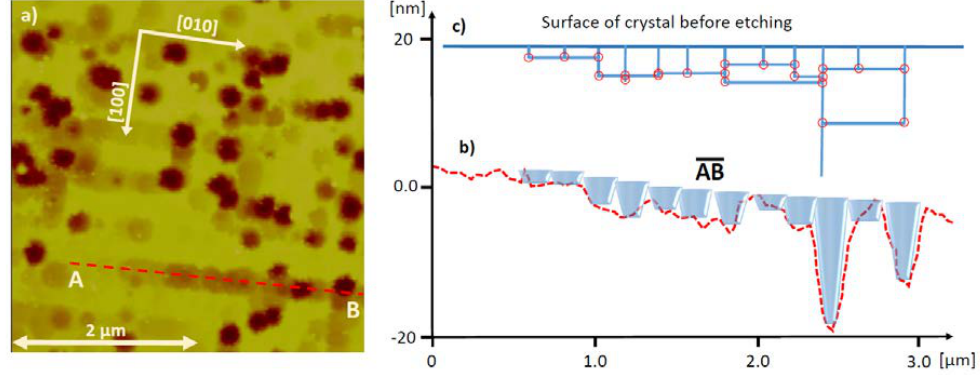
Figure 8. ( a ) AFM-topographic picture of etch pits on SrTiO 3 (100) surface (for the decoration of the exit of dislocation only a short etching was applied). The determined density of dislocation is 1.5 × 10 10 per cm 2 . ( b ) Cross-section (A–B) shows a variation of the depths of the etch pits. Inset ( c ) shows a possible 2D projection of a three-dimensional arrangement of the dislocations in a network of dislocations in surface layer of SrTiO 3 ; red circles mark the nodes of dislocations network, which fulfill the criterion that in such nodes the sum of Burgers vectors has to vanish. This scheme illustrates a dramatic reduction of the density of dislocations from the outer surface to the deeper parts of the surface layer (region), which has been proved by TEM study [10,42] (for details see, e.g., [68] and sub-Section 5.3.3). Such a kind of network is typical for a so-called hierarchical tree of dislocation arrangement.